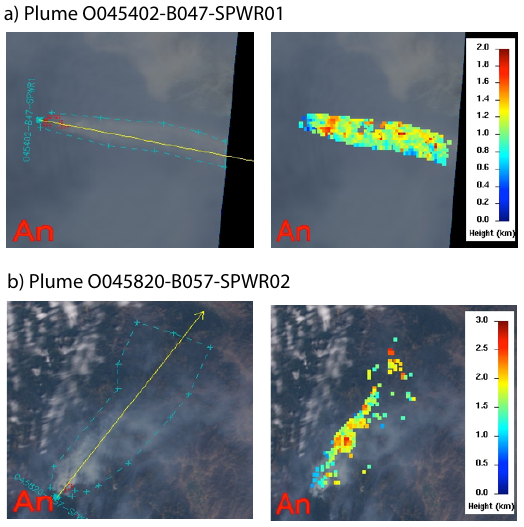
Figure 3. Examples of Plume Stereo-height Retrieval Density. ( a ) Plume O045402-B047-SPWR01 with high retrieval density (PtctHtsFilled = 84%) and high AOD (mean AOD558 = 1.05); ( b ) Plume O045820-B057-SPWR02 with low retrieval density (PtctHtsFilled = 40%) and lower AOD (mean AOD558 =